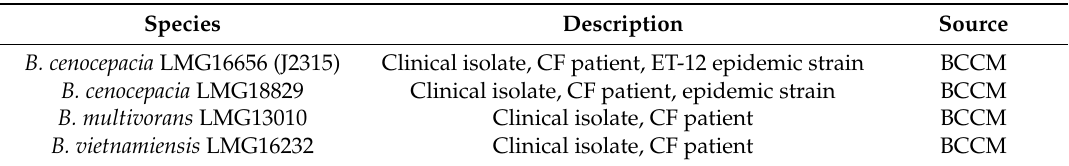
Table 1. Bacterial strains used in this study.